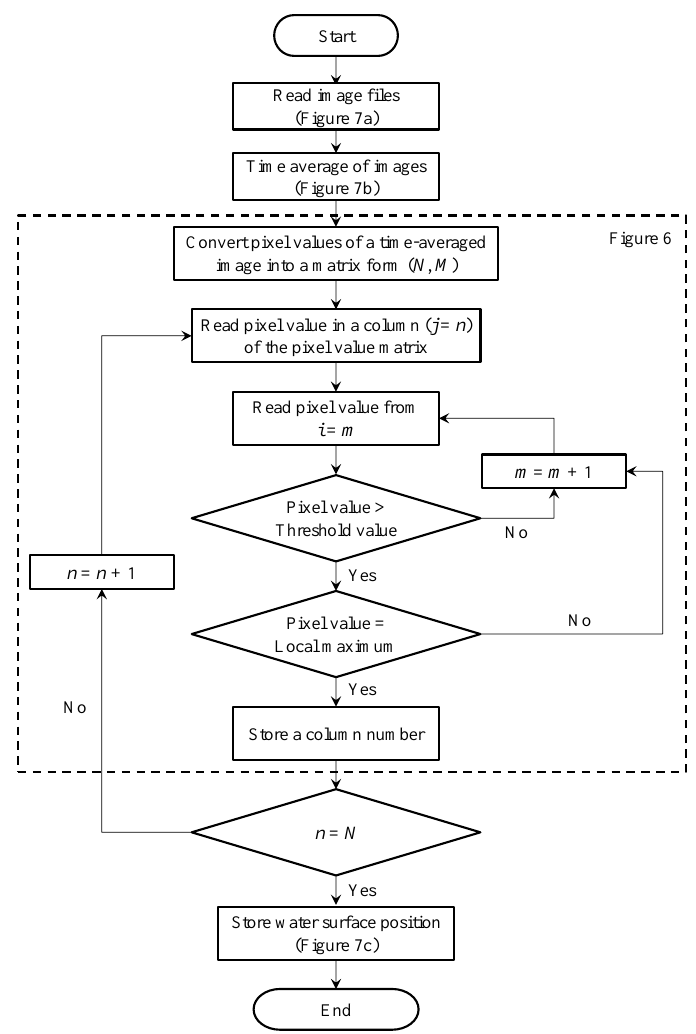
Figure 4. An algorithm for calculation of inundation depth from the laser image.